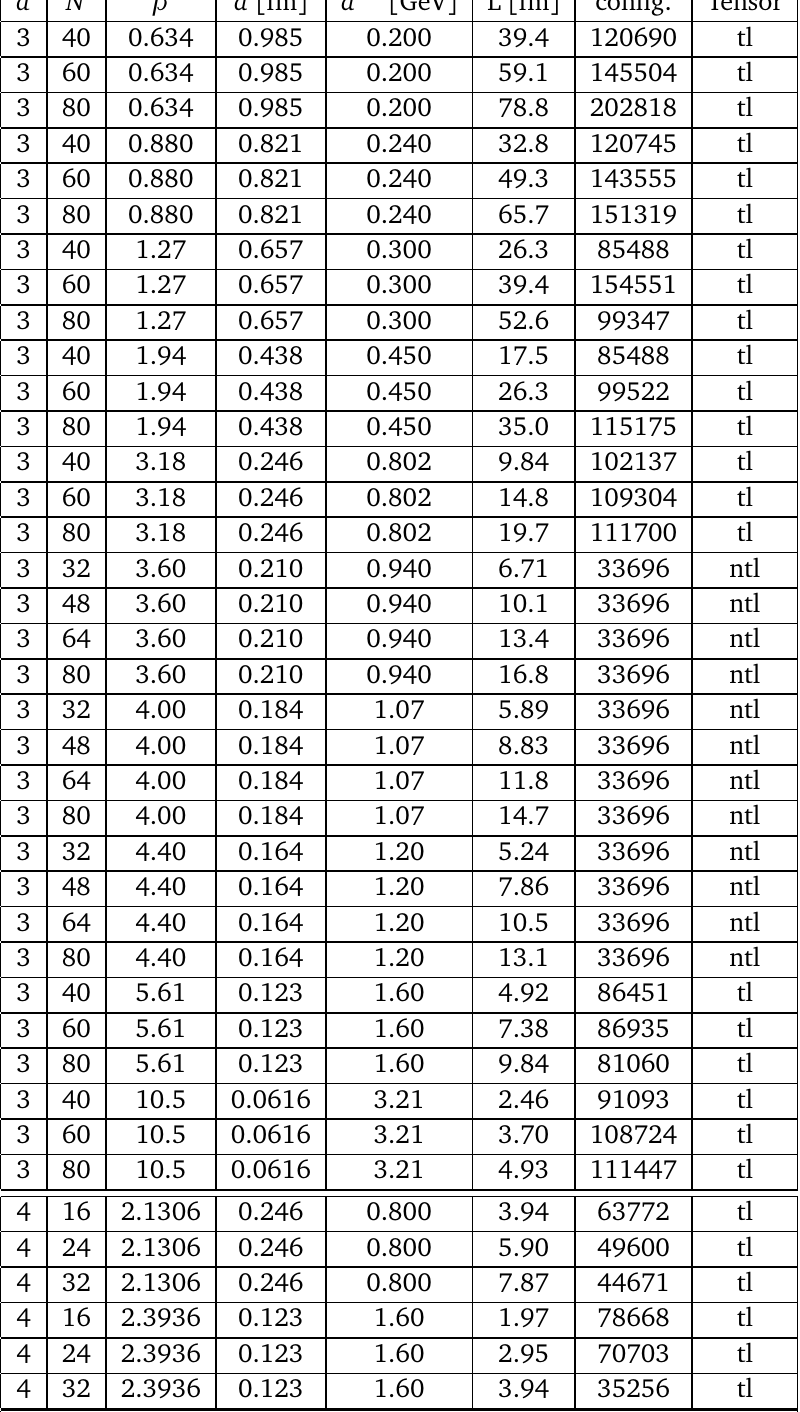
Table 1: Number and parameters of the configurations used, ordered by dimen- sion, lattice spacing, and physical volume. See [ 12, 23 ] for technical details. Auto- correlation times of local observables have been monitored to ensure decorrelation. See [ 24 ] and appendix A on details of how the lattice spacing was determined. Con- fig. is the number of configurations. Tensor indicates whether this setting has been used to determine tree-level (tl) or non-tree-level (ntl) form